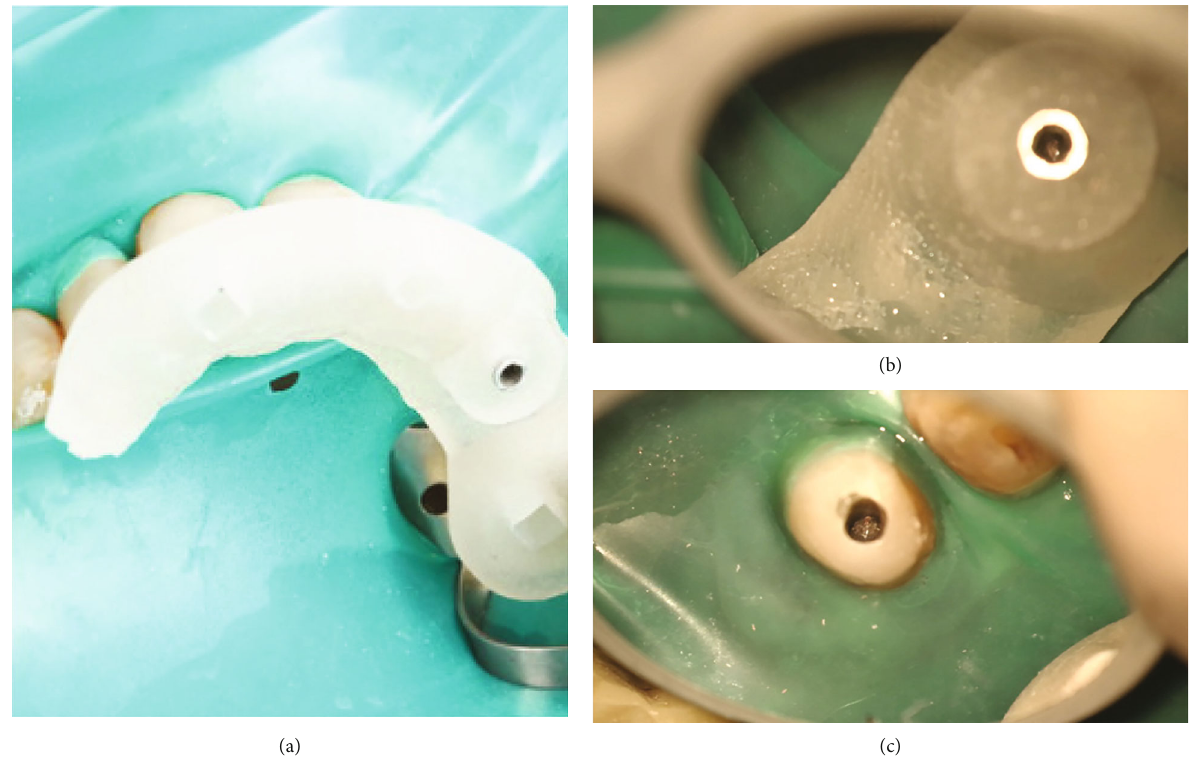
Figure 4: (a) Under rubber dam isolation, the guide was positioned on the teeth to check the correct fi tting. (b, c) Intracanal space following complete removal of the fi ber post with coronal gutta-percha exposure.